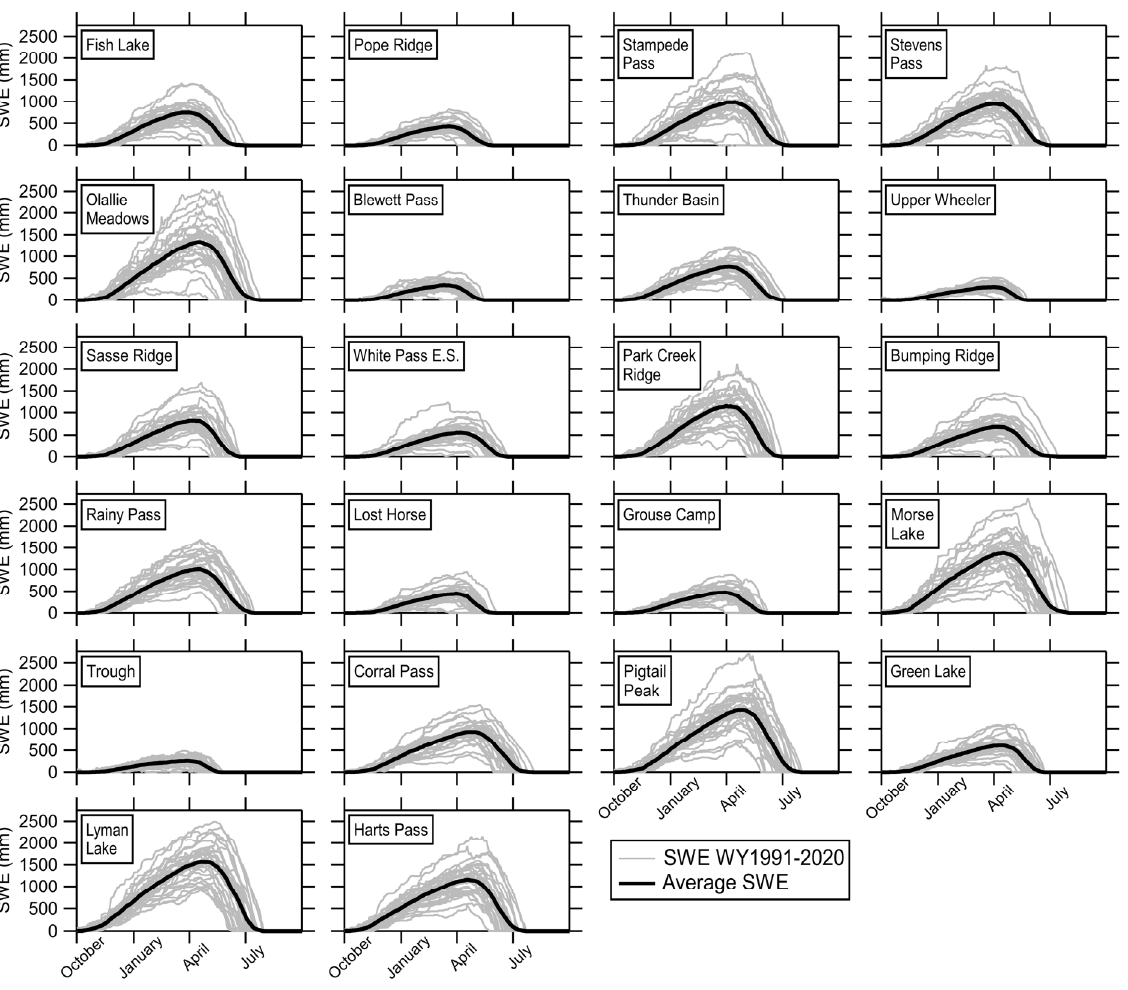
Figure 3. SWE for WY1991–WY2020 at 22 SNOTEL stations (see information in Figure 1 and Table S1). Gray lines indicate SWE for each WY and the black solid line is the average SWE for the WY1991-WY2020. The marks on the x -axis indicate the first day of each month.